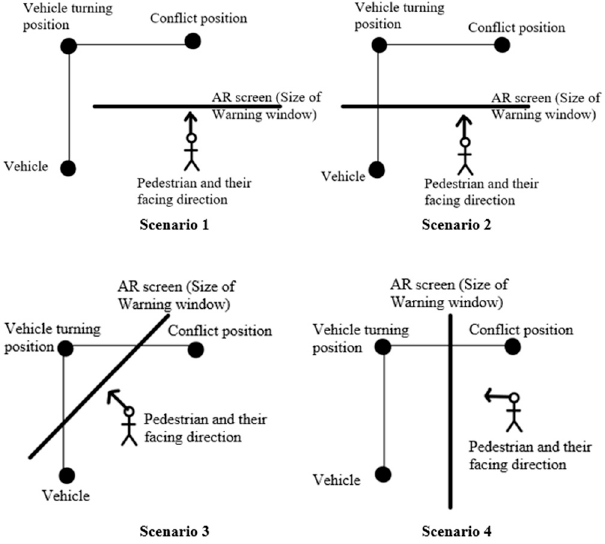
Figure 6. Four scenarios in which perspective projection did not work well.